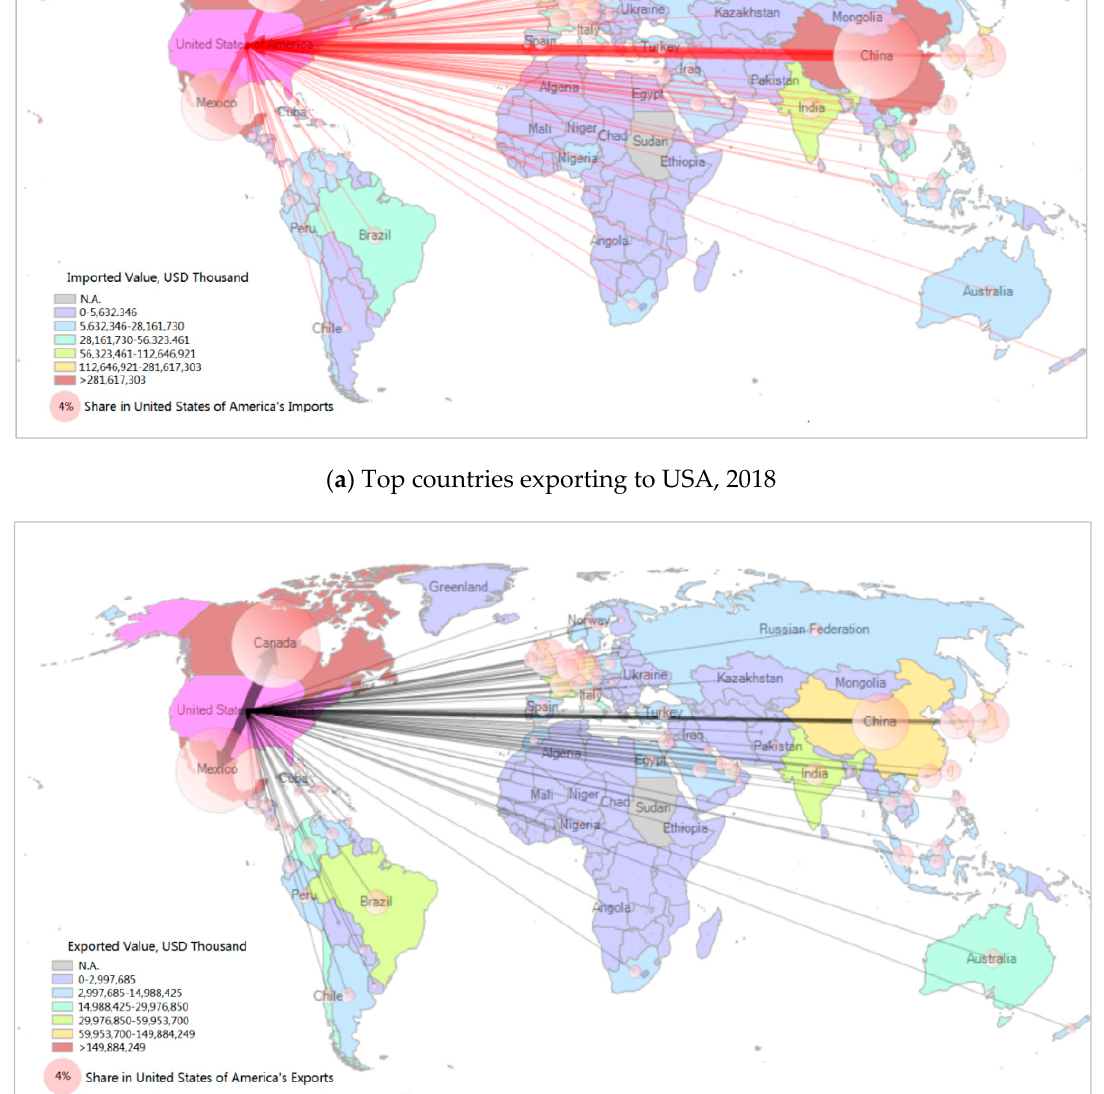
Figure 4. Top countries importing and exporting with the U.S., 2018.